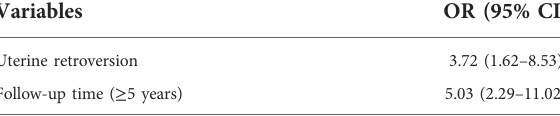
TABLE 2 Multivariate regression analysis of the risk factors for DE.